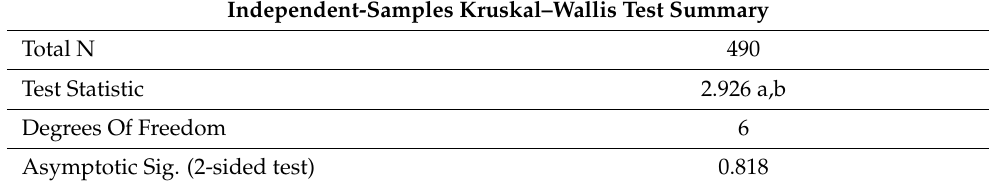
Table A10. Effects on error rate (attention to details).